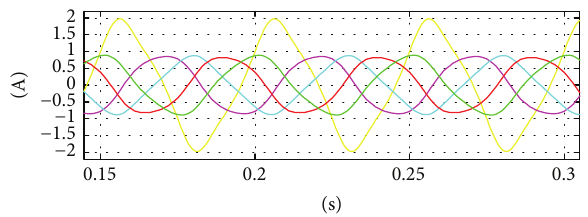
Figure 6: The phase current waveforms in fault state ( 𝑢 = 0.5